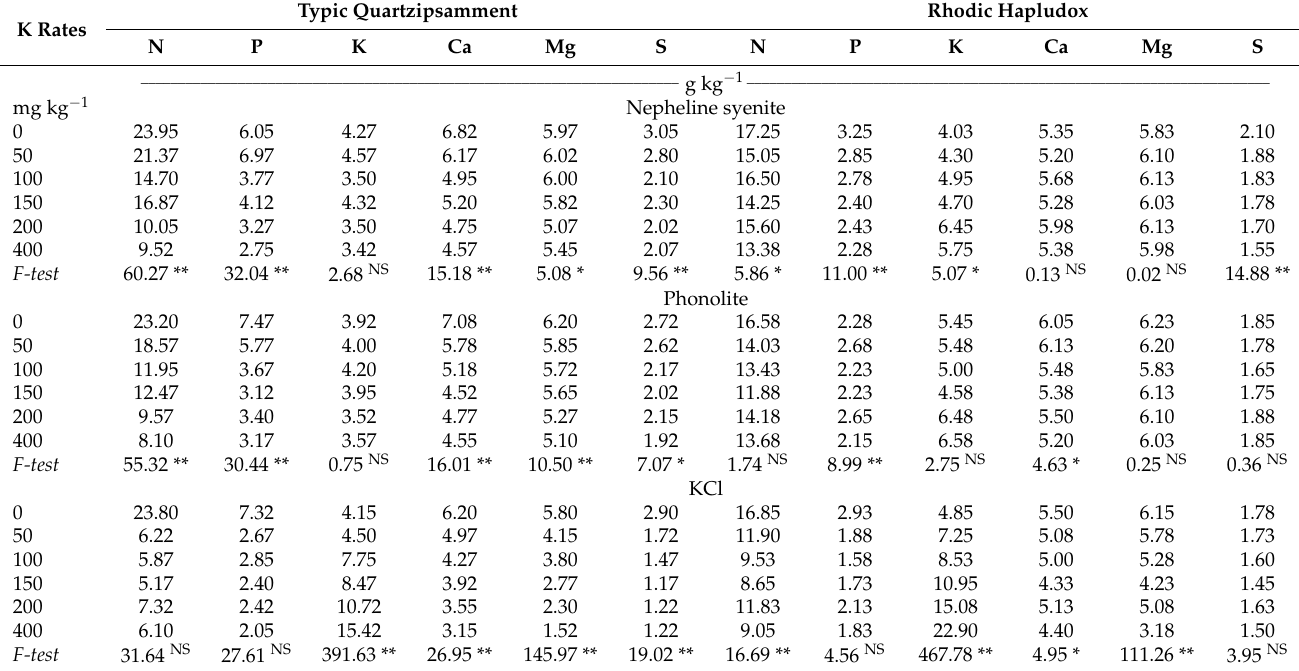
Table 10. Concentration of macronutrients in the shoots of maize plants grown in the Typic Quartzipsamment and in the Rhodic Hapludox, depending on the rates and sources of